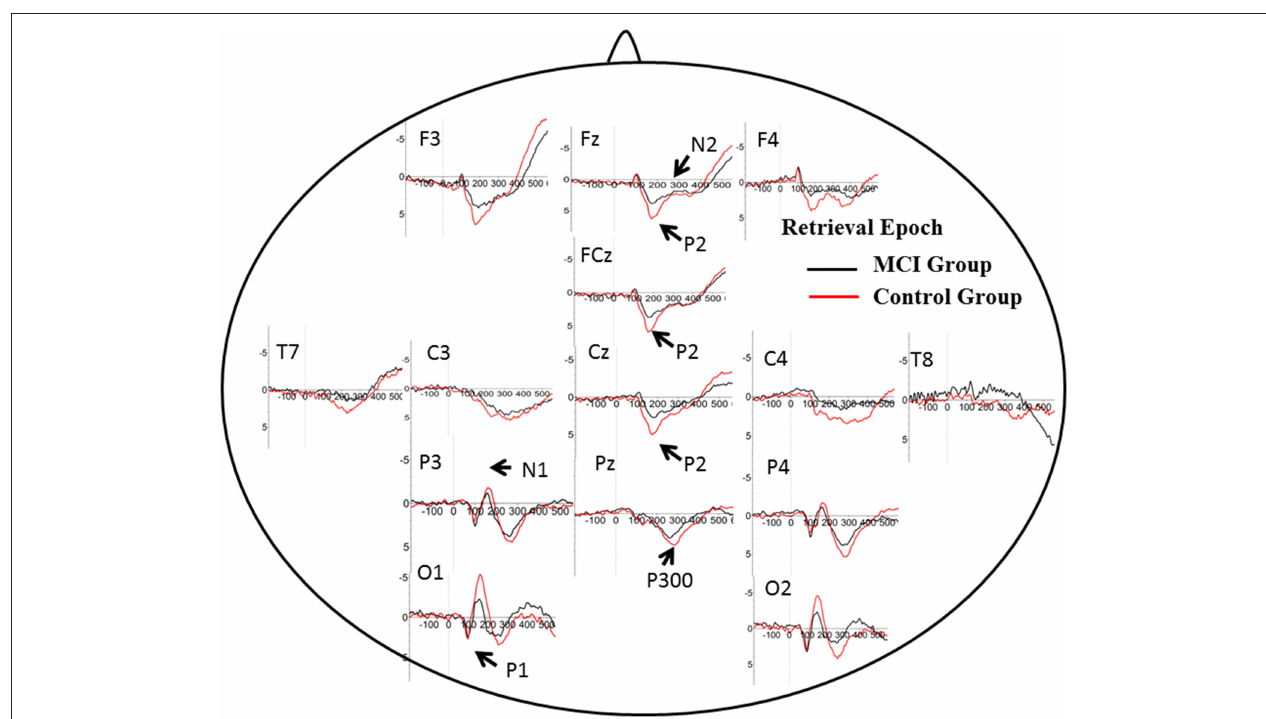
FIGURE 3 | Grand average ERP waveform in aMCI (black line) and normal control group (red line) during encoding period in WM task. Time was shown in milliseconds where stimulus onset was at 0, and potentials were shown in micro-voltage.